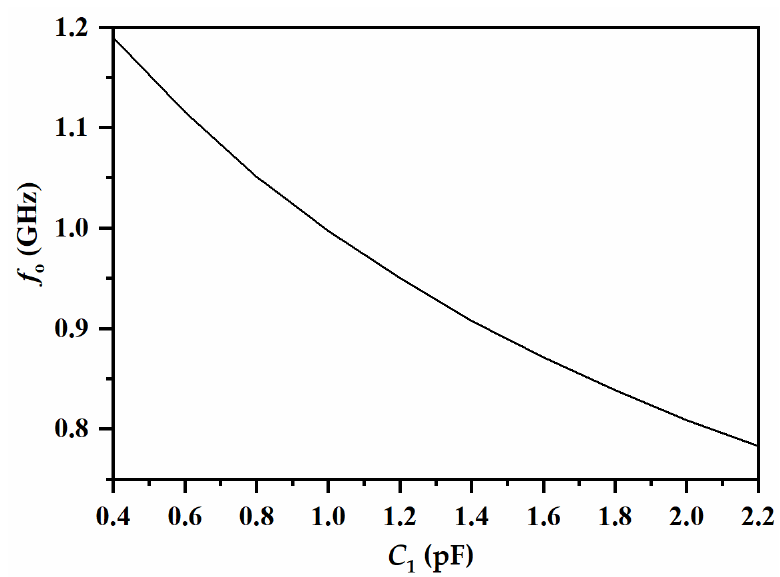
Figure 2. Odd-mode resonant frequency f o versus C 1 ( Y 1 = 1/75 S, Y 2 = Y 3 = 2/75 S, θ 1 = 65°, θ 2 = 60° and θ 3 = 35° at 1 GHz).